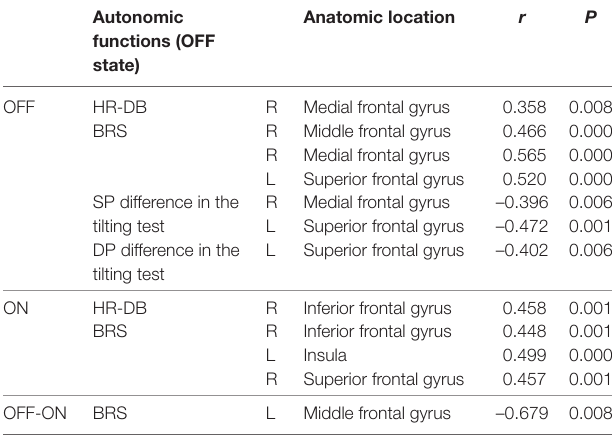
differences in CBF value after controlling for age, gender, and BMI. autonomic functions (OFF